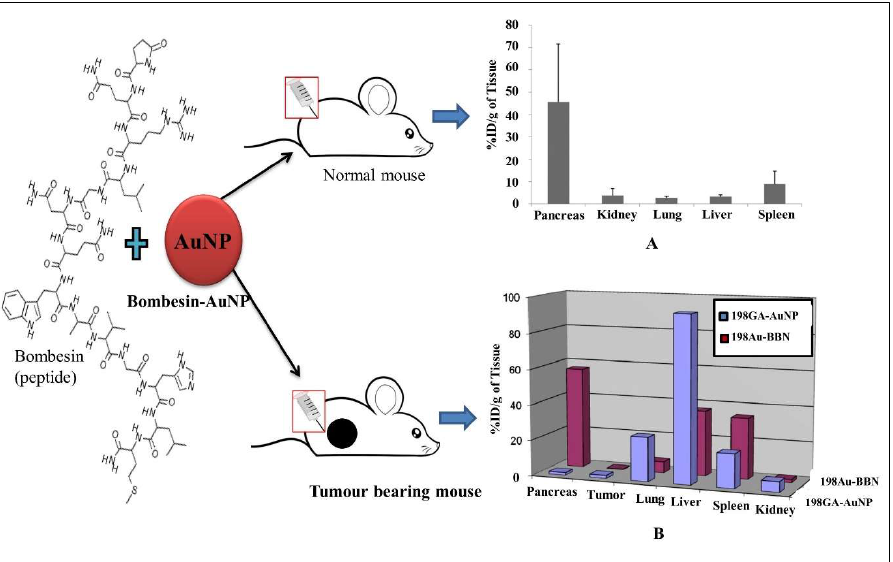
Figure 5. Bombesin-conjugated gold nanoparticles. ( A ) Concentration of conjugated nanoparticles in different organs after intraperitoneal administration in normal mice. ( B ) Comparison of bombesin (BBN) conjugated and gum arabic (GA) functionalized gold nanoparticle uptake after intraperitoneal administration in tumor-bearing mice. Selective uptake into the pancreas via the bombesin-specific receptor was observed. Adapted from ref. [206] with permission, PNAS.